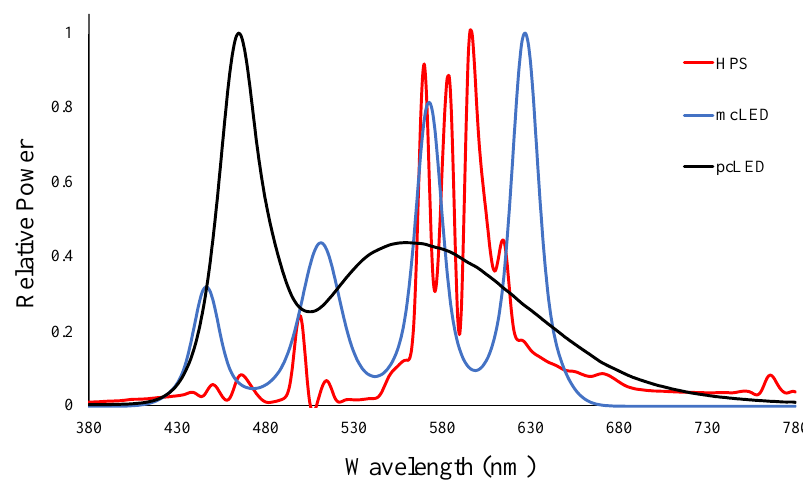
Figure 2. High-pressure sodium (HPS, red line) lamps are widely used in horticulture as grow lamps. LEDs offer a wide range of spectral power distributions. Two of the most widely used LED types are multi-colored LED (mcLED, blue line) and phosphor-coated LED (pcLED, black line).